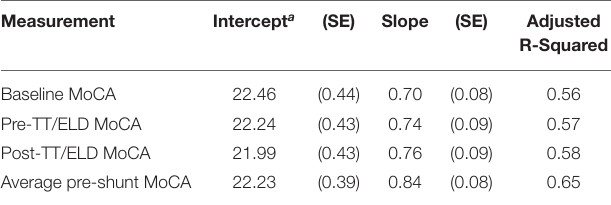
TABLE 3 | Univariate regressions of post-shunt MoCA on prior MoCA